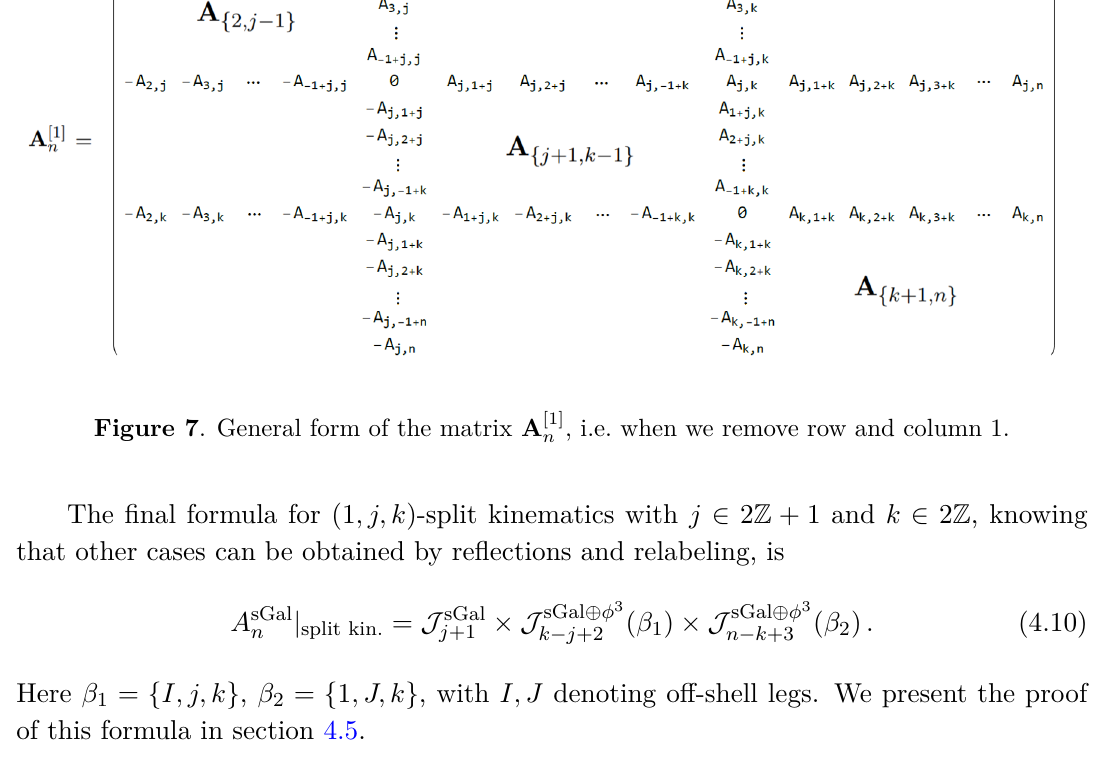
The final formula for (1 , j, k ) -split kinematics with j ∈ 2 Z + 1 and k ∈ 2 Z ,